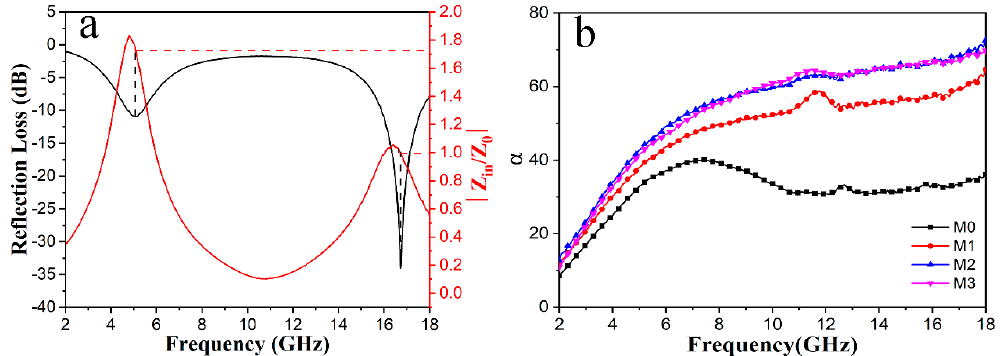
Figure 10. RL value and impedance matching curve of M2 with thickness of 5 mm ( a ), attenuation constant curves of M0, M1, M2, and M3 ( b ).